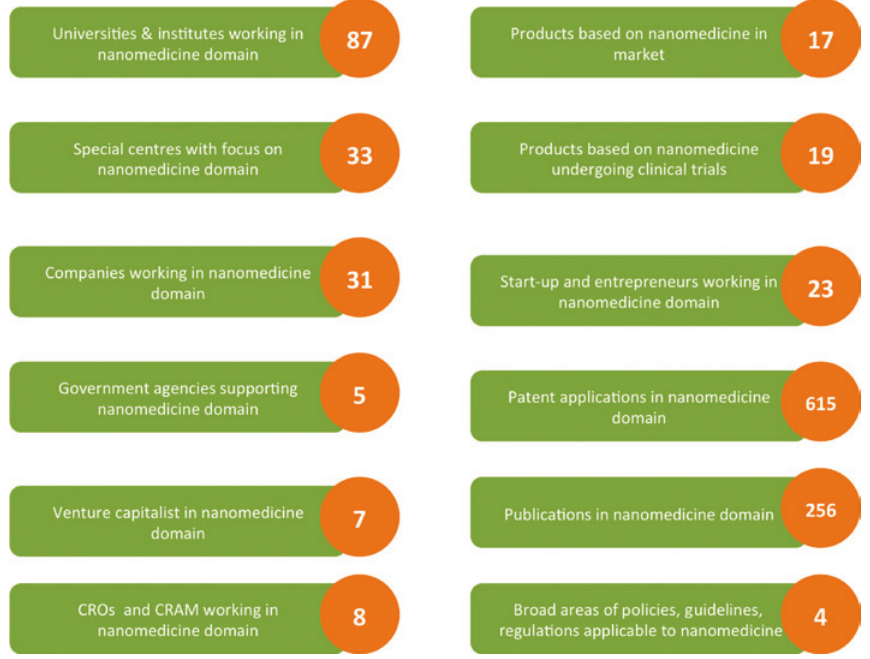
Figure 3: Nanomedicine innovation in India. A landscape of nanomedicine innovation in India has been mapped depicting various stake- holders involved in nanomedicine innovation, level of investment, and regulatory framework for nanomedicine. The numbers quantify the stakeholders, products, publications, and patents and relevant laws, policies and